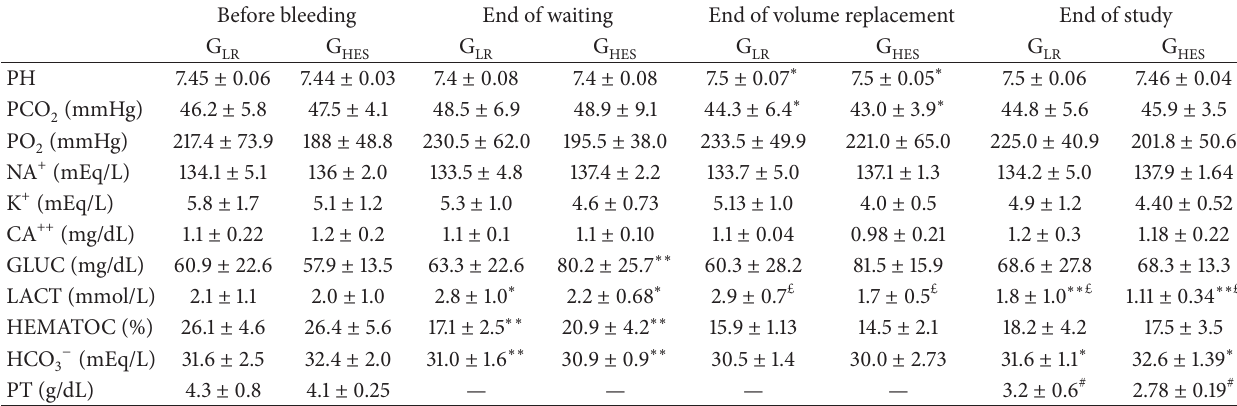
Table 1: Results from arterial blood gas analysis performed before the beginning of bleeding (1), at the end of the waiting period (2), in the end of the volume replacement (3), and in the end of the study one hour after the end of the volume replacement (4). Before bleeding End of waiting End of volume replacement End of study G LR G HES G LR G HES G LR G HES G LR G HES